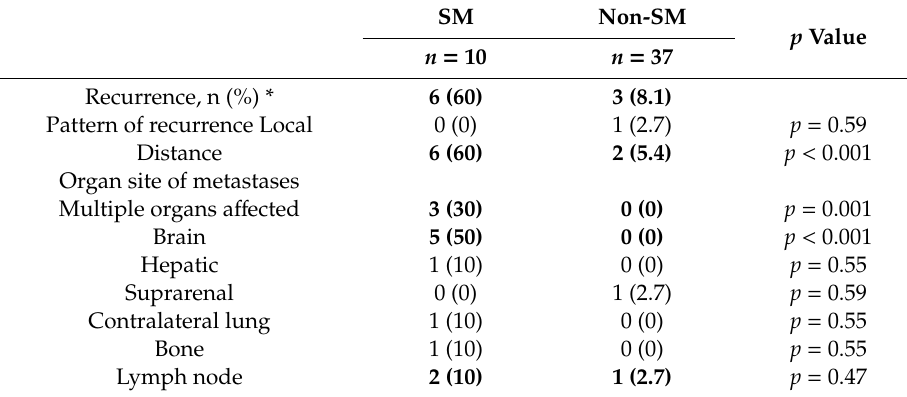
Table 3. Pattern of recurrence in mutated